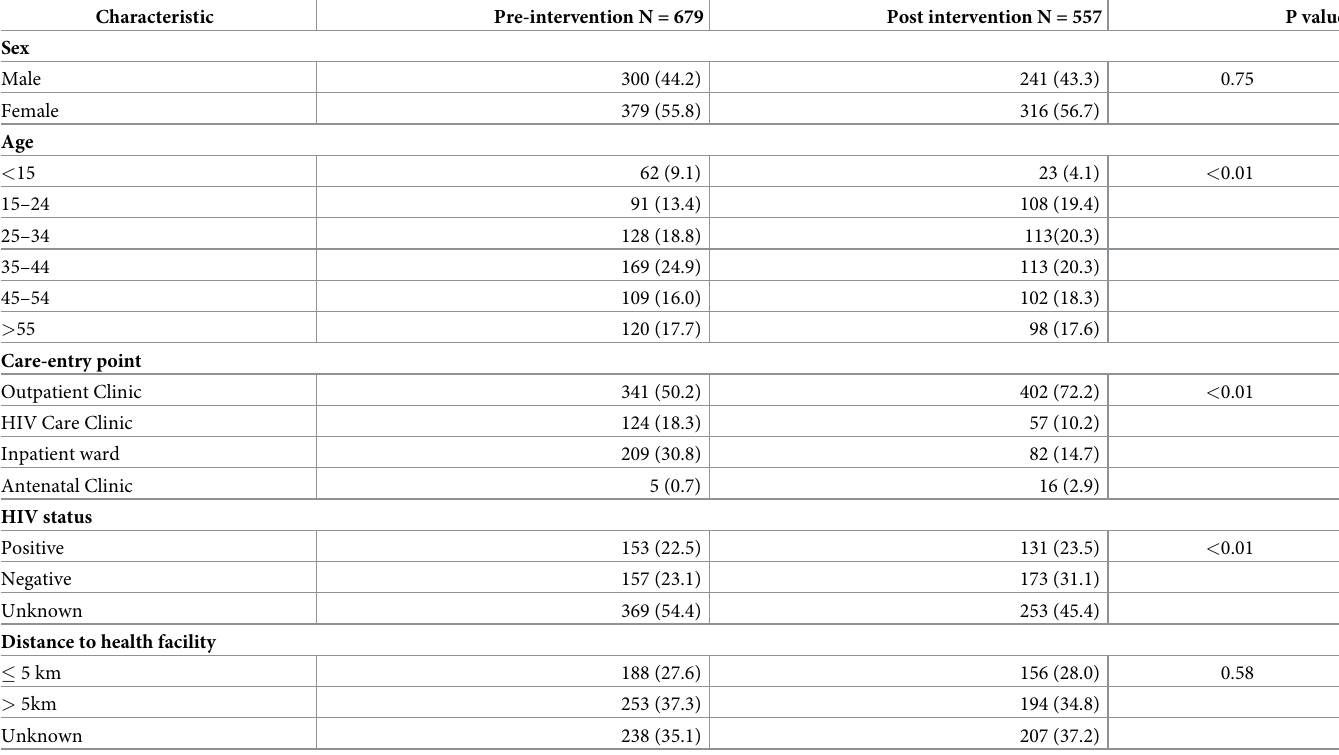
Table 1. Baseline characteristics of patients.